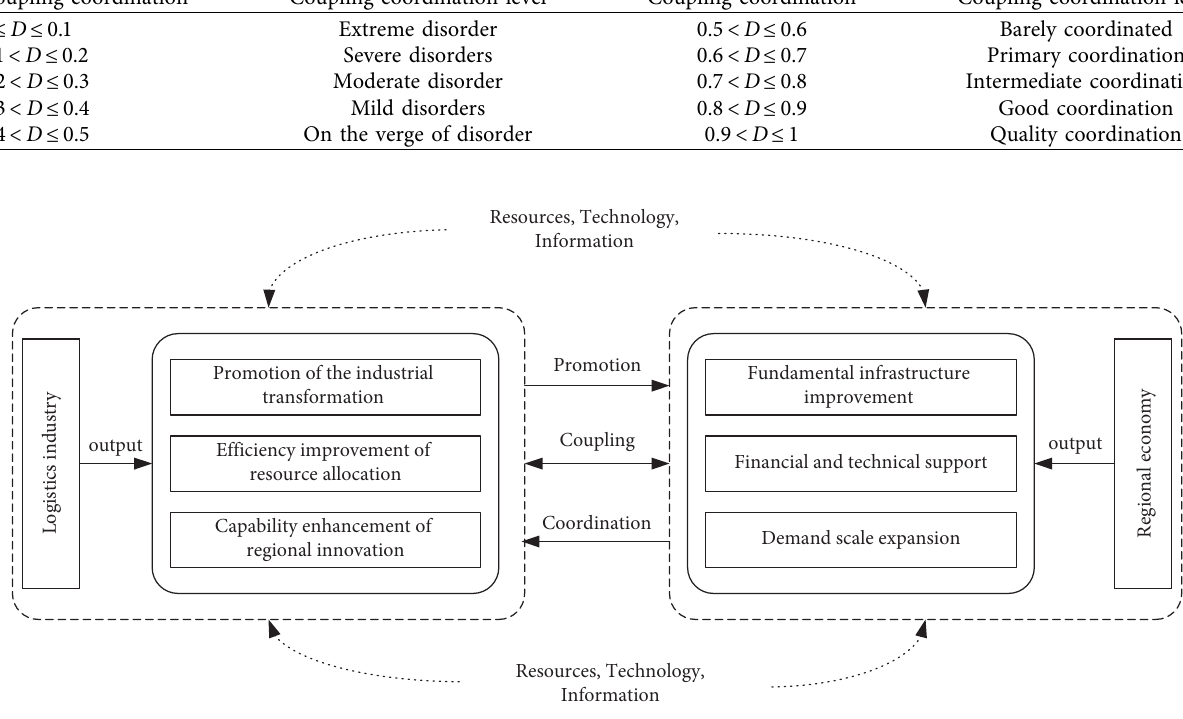
Figure 1: Logistics industry and economic coupling and coordination